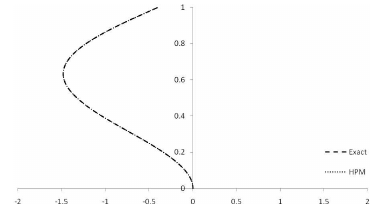
Figure 6. Mode shapes for the second mode – constant stiffness.